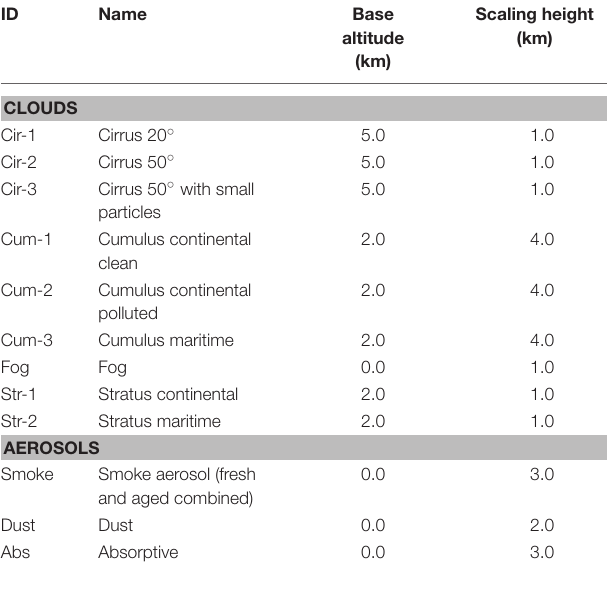
TABLE 1 | Optical models used in “cloud”